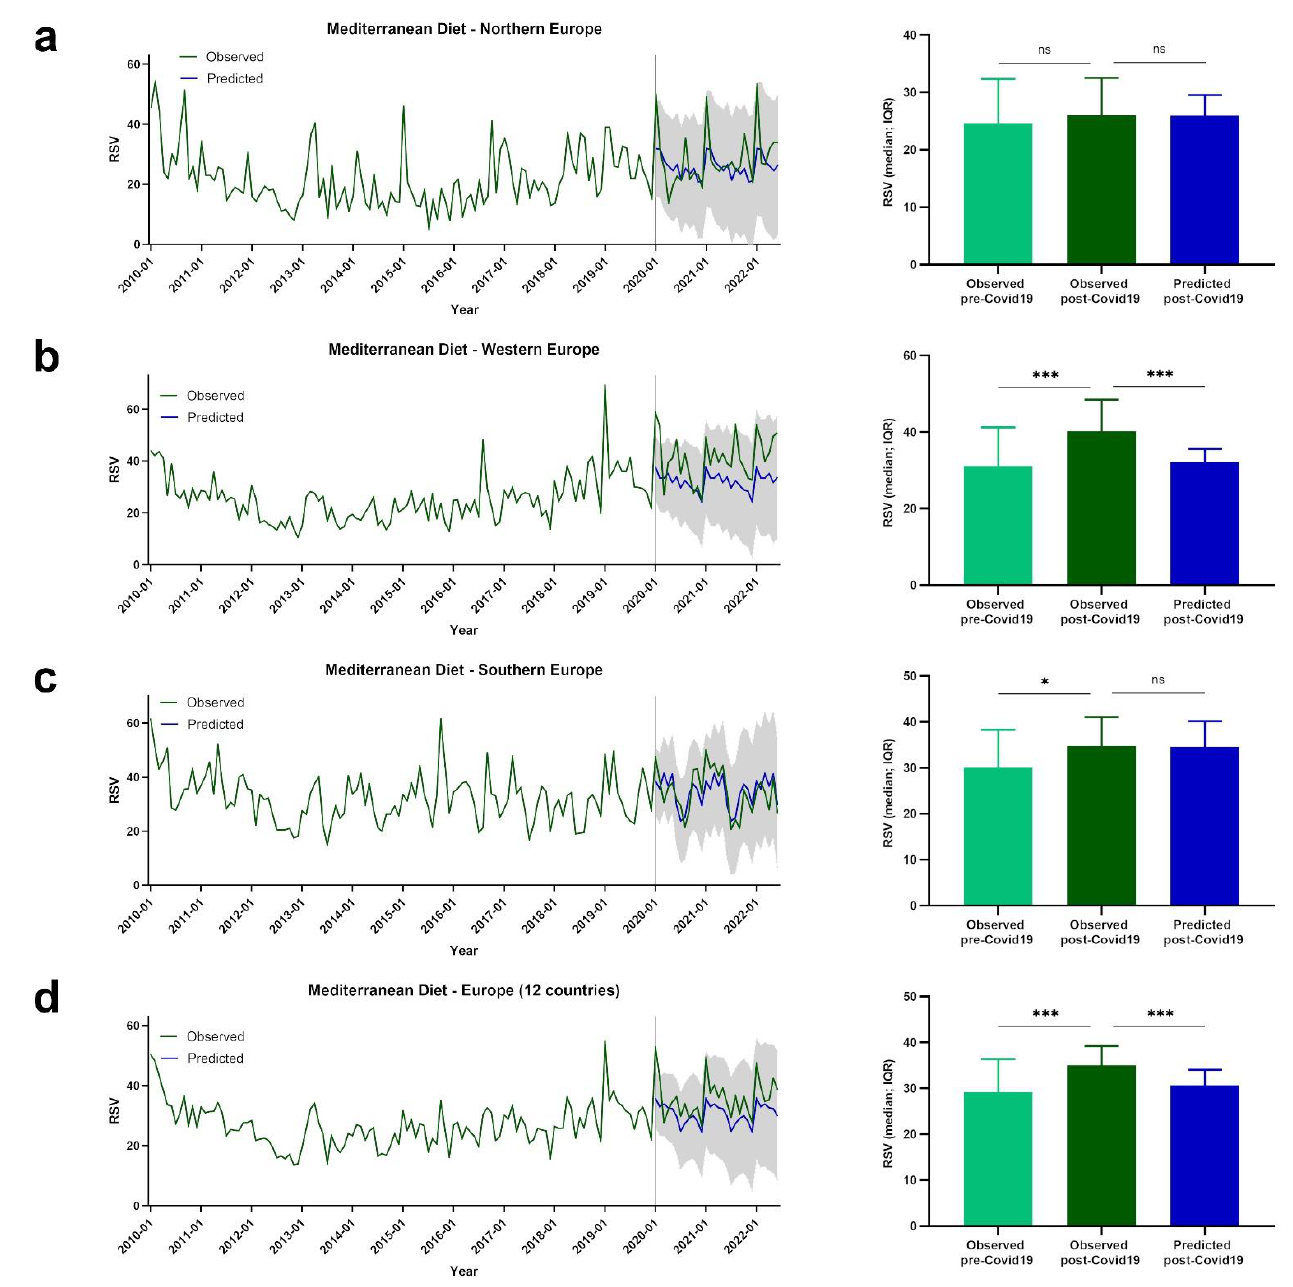
Figure 5. The RSV evolution for MedDiet topic. ( a ) Evolution of RSVs for MedDiet topic in northern Europe from January 2010 to June 2022 (green line), predicted evolution of RSVs for MedDiet topic between January 2020 and June 2022 (blue line); gray shadow represents 95% confidence interval. ( b ) Evolution of RSVs for MedDiet topic in western Europe from January 2010 to June 2022 (green line), predicted evolution of RSVs for MedDiet topic between January 2020 and June 2022 (blue line); gray shadow represents 95% confidence interval. ( c ) Evolution of RSVs for MedDiet topic in southern Europe from January 2010 to June 2022 (green line), predicted evolution of RSVs for MedDiet topic between January 2020 and June 2022 (blue line); gray shadow represents 95% confidence interval. ( d ) Evolution of RSVs for MedDiet topic in Europe from January 2010 to June 2022 (green line), predicted evolution of RSVs for MedDiet topic between January 2020 and June 2022 (blue line); gray shadow represents 95% confidence interval. For ( a – d ) bars represent the comparison between median RSVs pre-COVID-19 and post-COVID-19, and between post-COVID-19 and predicted post-COVID-19 data. * p < 0.05; *** p < 0.001; ns — not significant.